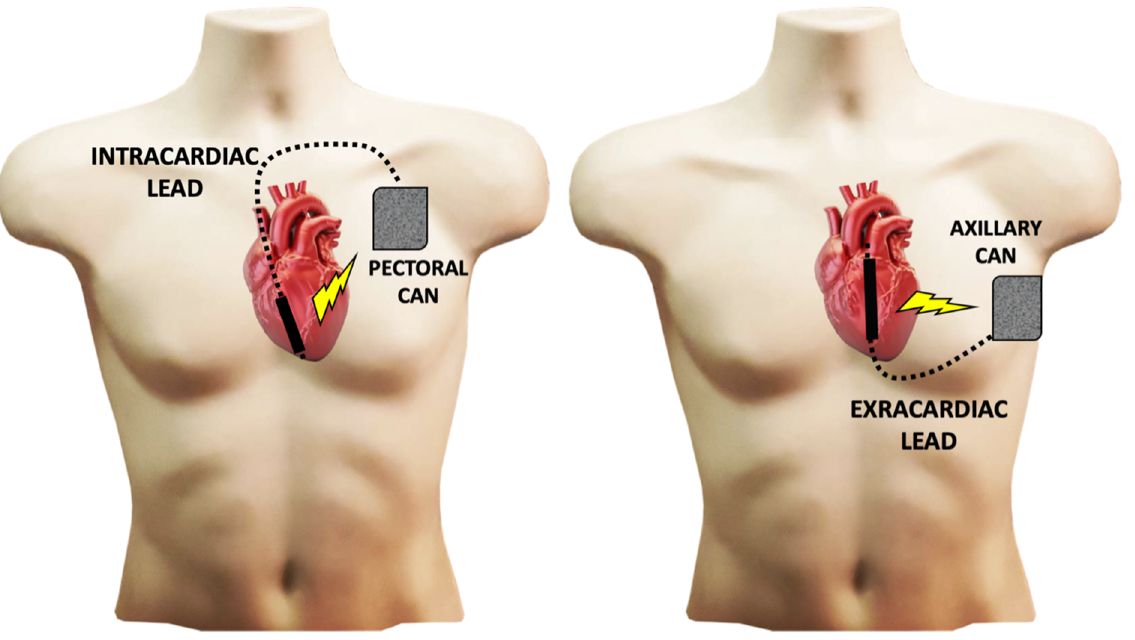
Figure 1. Main implantable cardiac defibrillators (ICD) technologies on the market. The historical technique uses a subcutaneous or submuscular can and an intracardiac lead implanted in the right ventricle through supra-caval venous access (Left Panel). Extracardiac technologies use an axillary can and a defibrillation lead tunneled subcutaneously in a para-sternal position or directly under the sternum in a para-cardiac position (Right Panel). Shocks are delivered between the hot can and the defibrillation lead